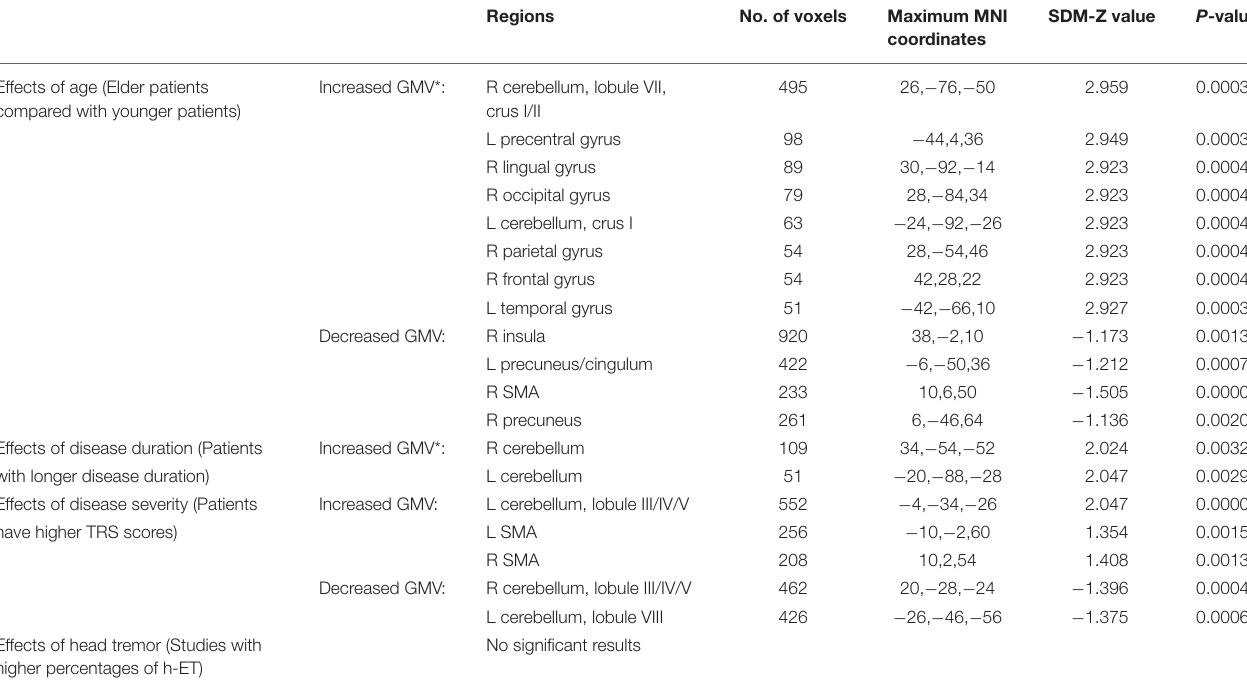
TABLE 4 | Factors affecting GMV in ET patients compared with healthy controls.